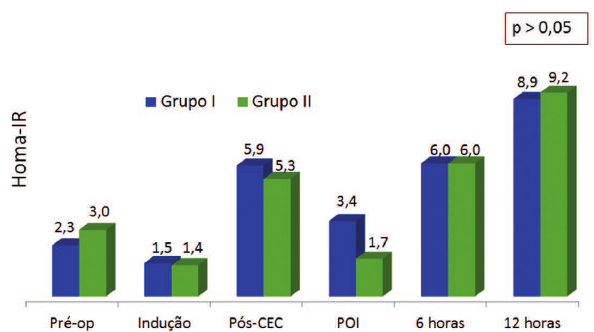
Fig. 4 - Comparação dos resultados dos valores medianos do índice de Homa-IR para os pacientes dos grupos I e II, nos diversos períodos de análise.